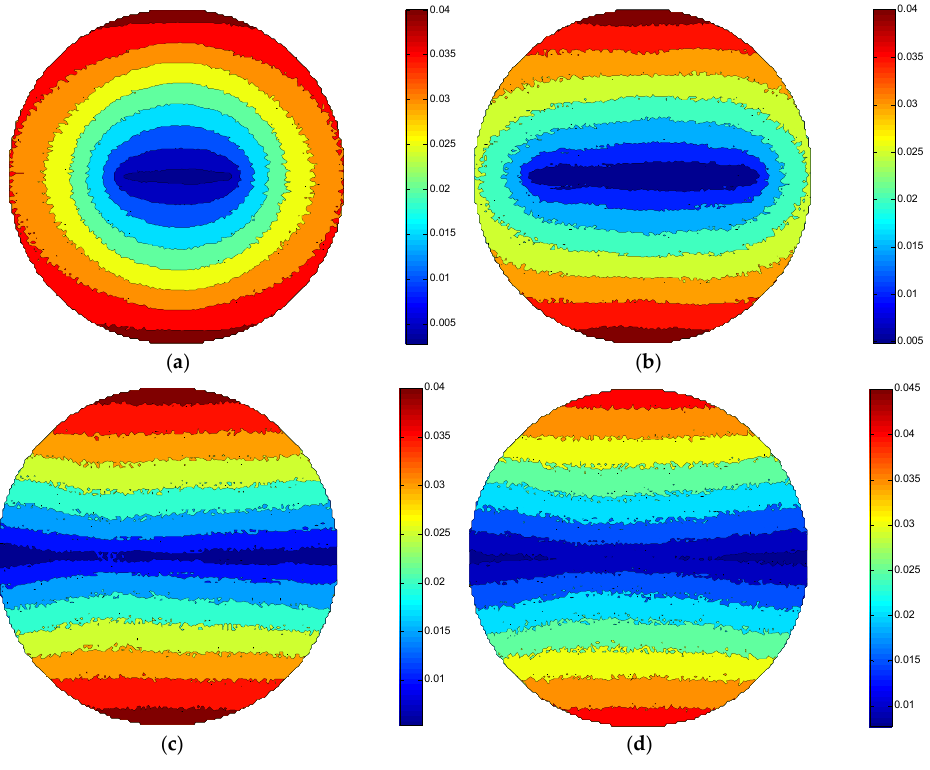
Figure 7. Distribution of MRR under different eccentricity conditions: ( a ) e = 0.005 m, ( b ) e = 0.01 m, ( c ) e = 0.02 m, ( d ) e = 0.04 m.